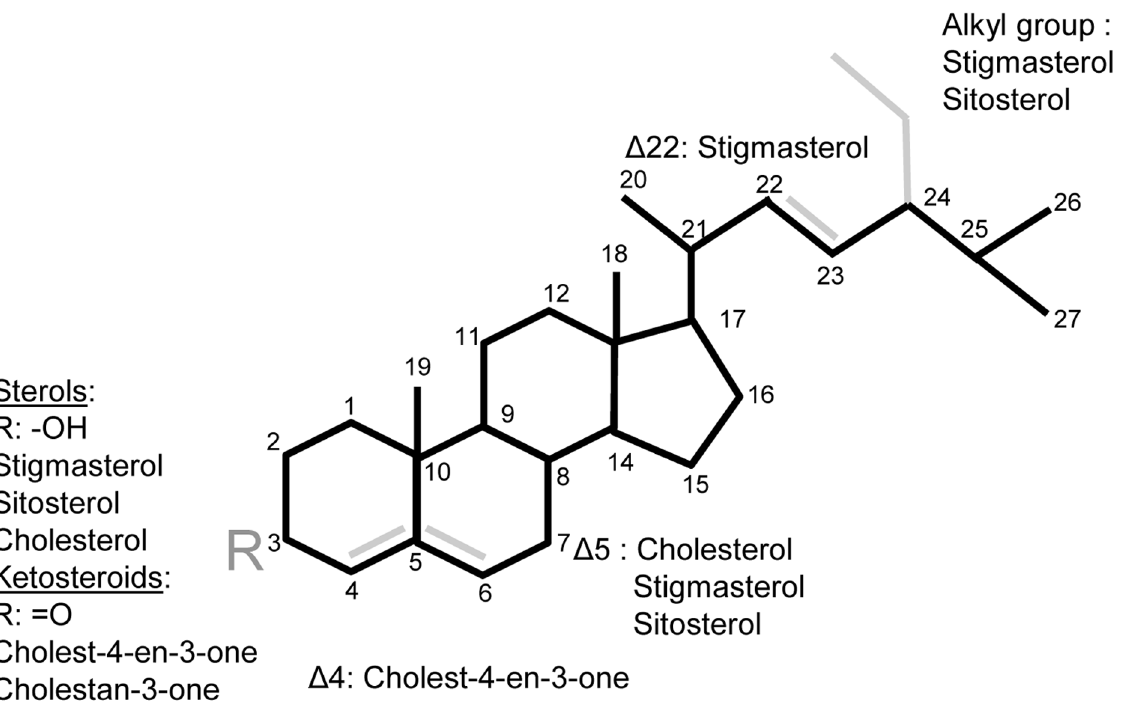
Figure 1. Structure of sterols and ketosteroids used in this study.